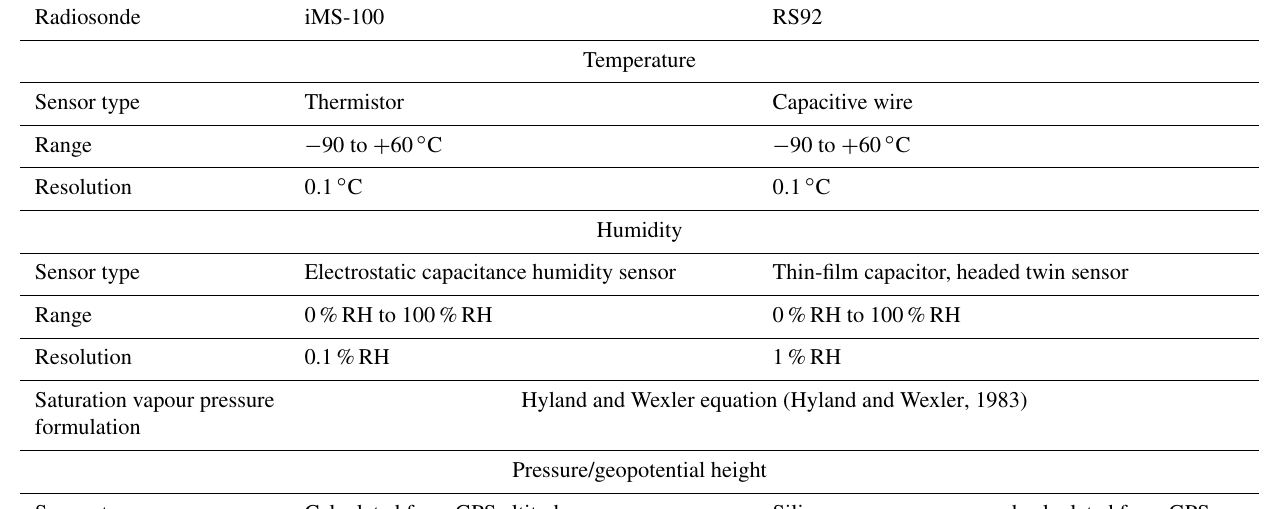
Table 1. Specifications of the radiosondes (Vaisala Oyj., 2013; Meisei Electric Co., Ltd., 2020; Dirksen et al., 2014; Hoshino et al., 2022a). Note: GBAS is ground-based augmentation system, SBAS is Satellite-Based Augmentation System, and DWH is depth, width, and